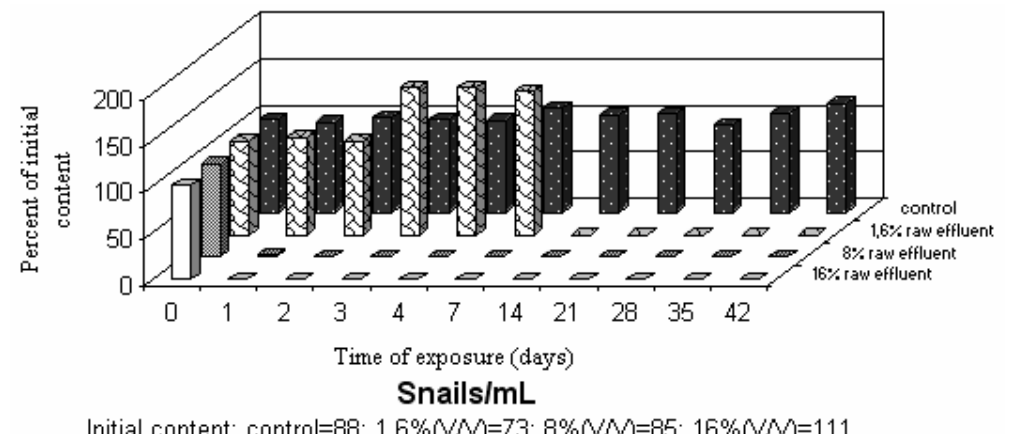
Figure 6: The effect of Pilcam effluent on aquatic snails’ density of untreated and treated